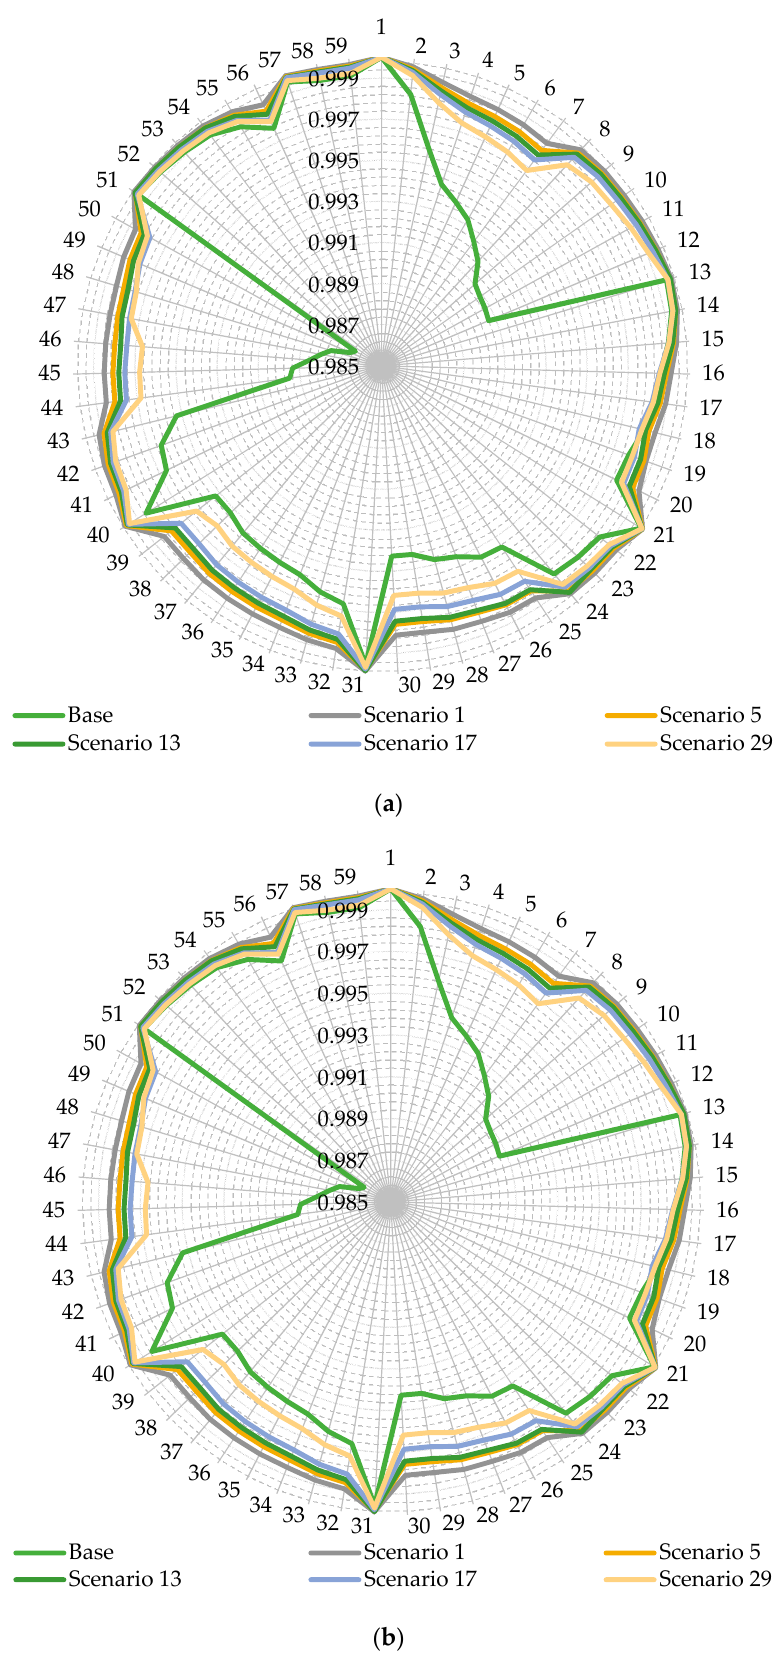
Figure 15. (cid:12) V k , s (cid:12) at multiple scenarios for the 59-node distribution network: ( a ) Via NSGA-II, and ( b ) Via MOPSO.